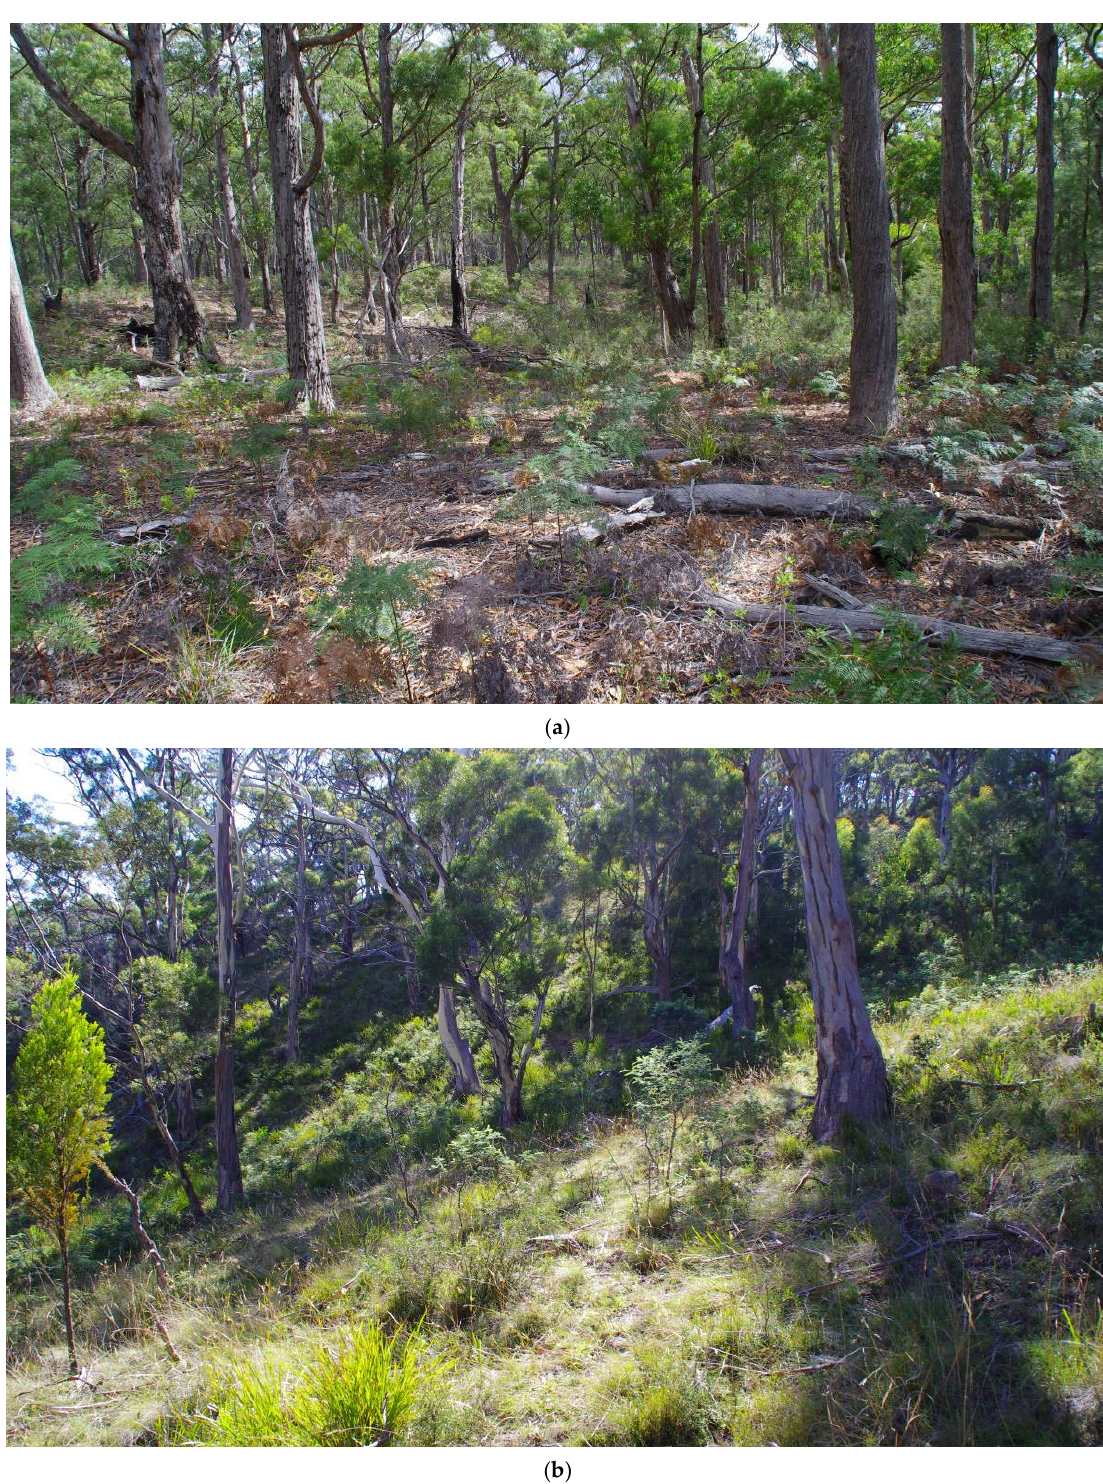
Figure 2. Typical dry forest vegetation structure. ( a ) Site 16: E. amygdalina dry forest, North Fraser Track in NE Tasmania, 17.4 years since fire. ( b ) Site 55: E. pulchella dry forest, Waterworks Reserve, SE Tasmania, 13.2 years since fire.